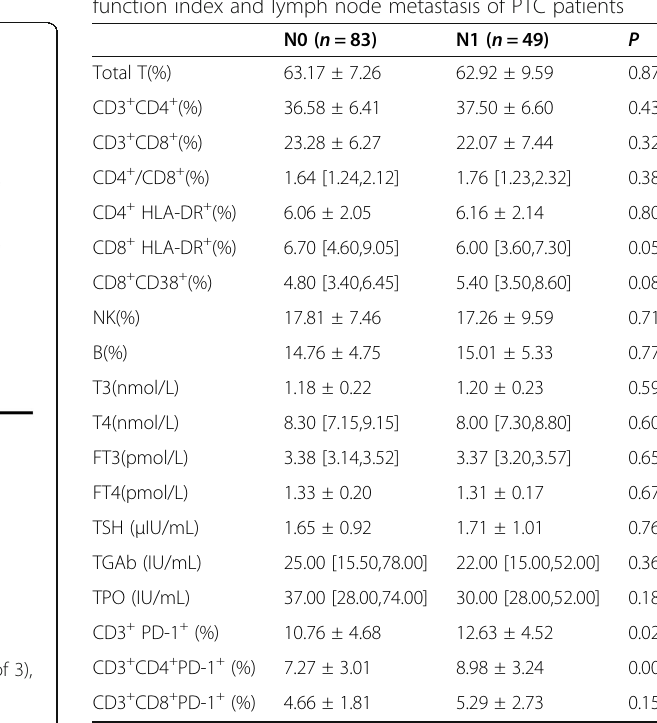
* represents significant differences ( p